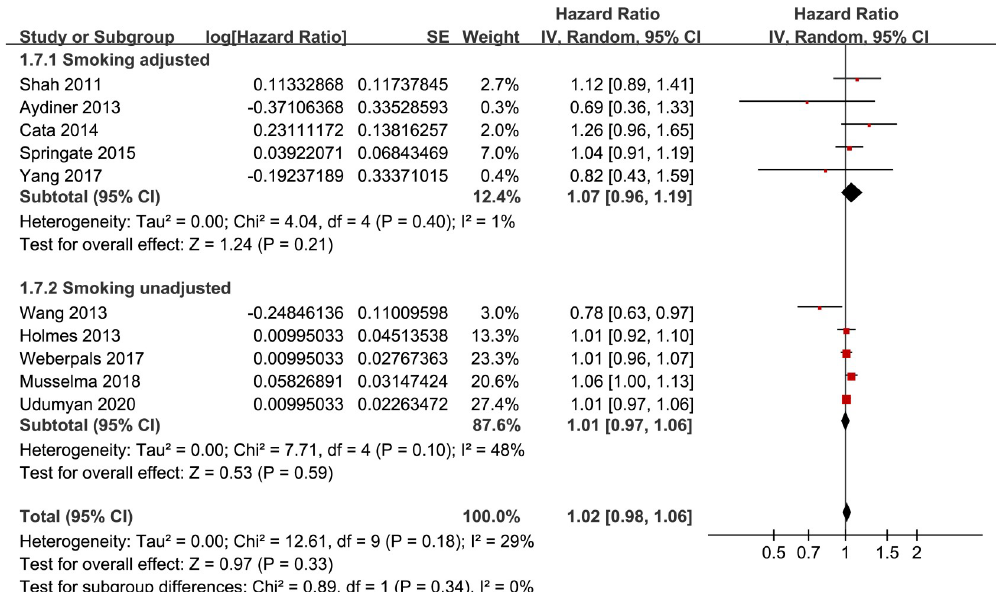
Fig 8. Stratified analyses for the meta-analysis of the association between BB use and OS of lung cancer according to whether smoking status was adjusted.